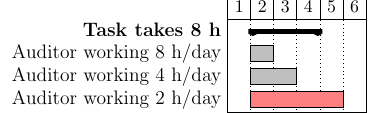
Fig. 5 Either of the auditors working 8 or 4 h per day can be assigned to the depicted task. However, an auditor working only 2 h per day would not be able to finish the task in